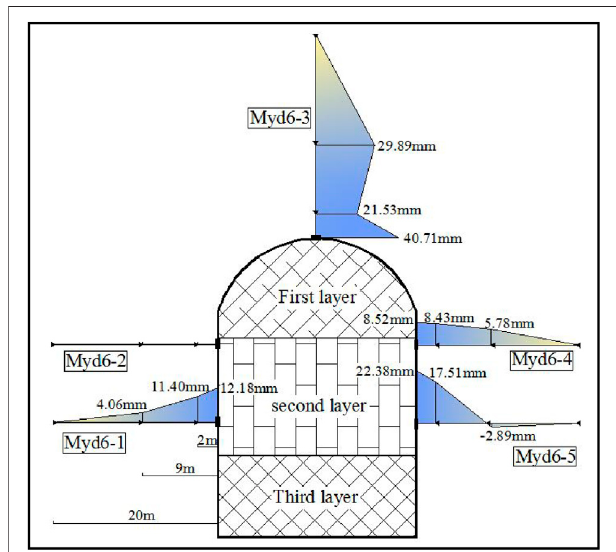
FIGURE 5 | Schematic diagram of layering excavation of No.4 diversion